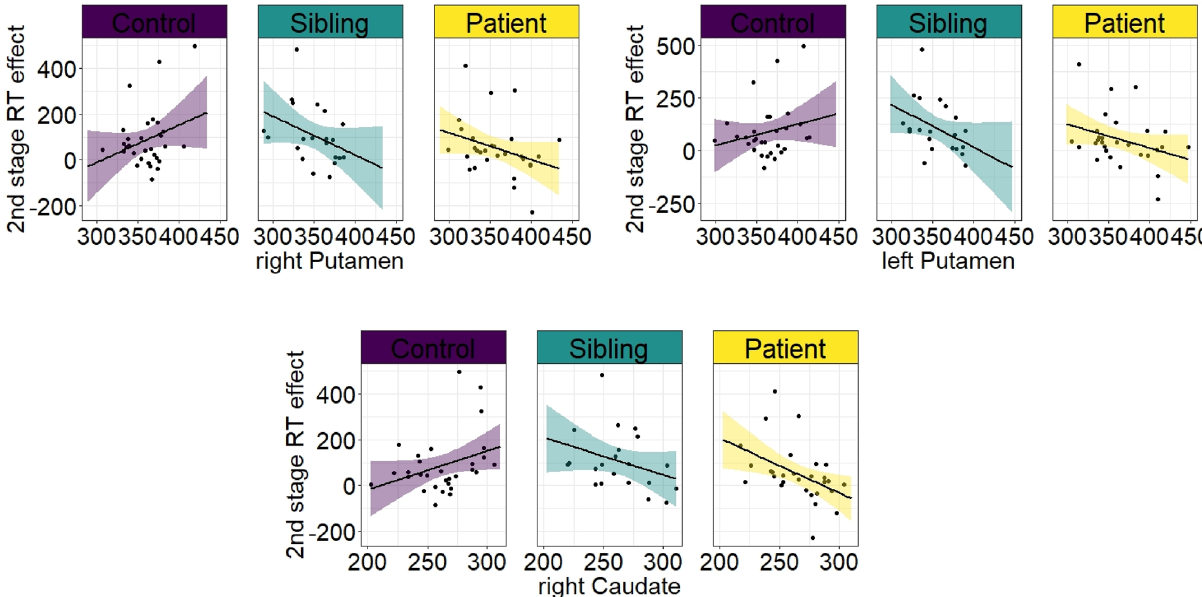
Figure 3. Association between 2nd stage RT effects and normalized volumes (× 10,000) of putamen and caudate nucleus. Across all subjects we found a negative association between 2nd stage RTs and volumes of left and right putamen and caudate nucleus. Interestingly these associations were particularly driven by Siblings and Patients ( A , B ) or patients alone ( C ) but not healthy controls ( A – C